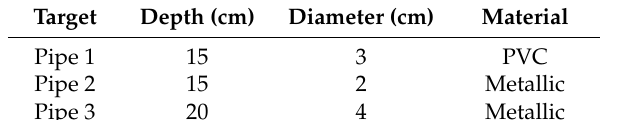
Figure 20. Three different pipes in the try sand trough. Table 4. The parameters of three pipes.